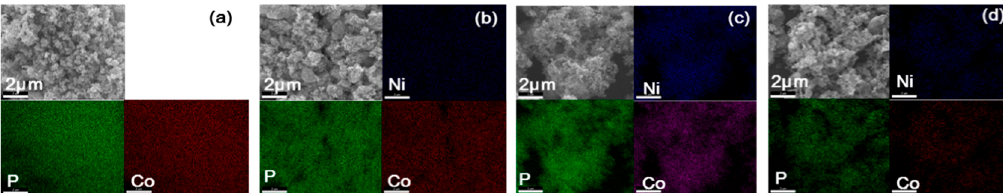
Figure 6. SEM images of ( a ) CoP, ( b ) NiCoP/CoP, ( c ) NiCoP and ( d ) NiCoP/Ni 2 P.